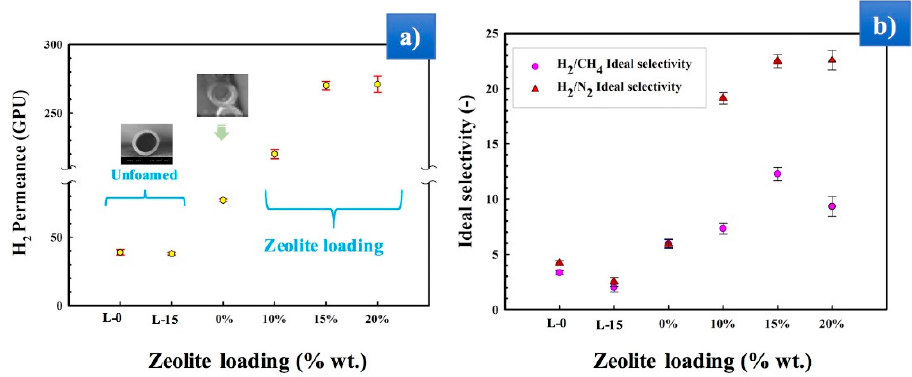
Figure 13. Permeation results for ( a ) H 2 gas permeance and ( b ) H 2 /CH 4 and H 2 /N 2 ideal selectivity at 30 ◦ C and 30 psia for different membranes as a function of zeolite loading.